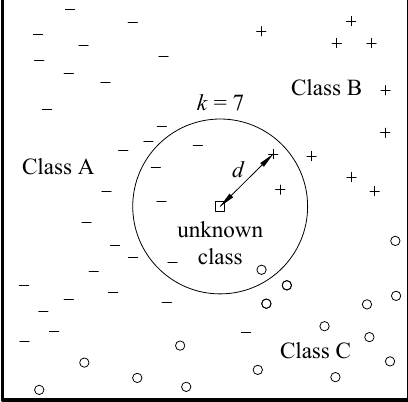
Figure 3. Sketch of the behaviour of a K-Nearest Neighbour